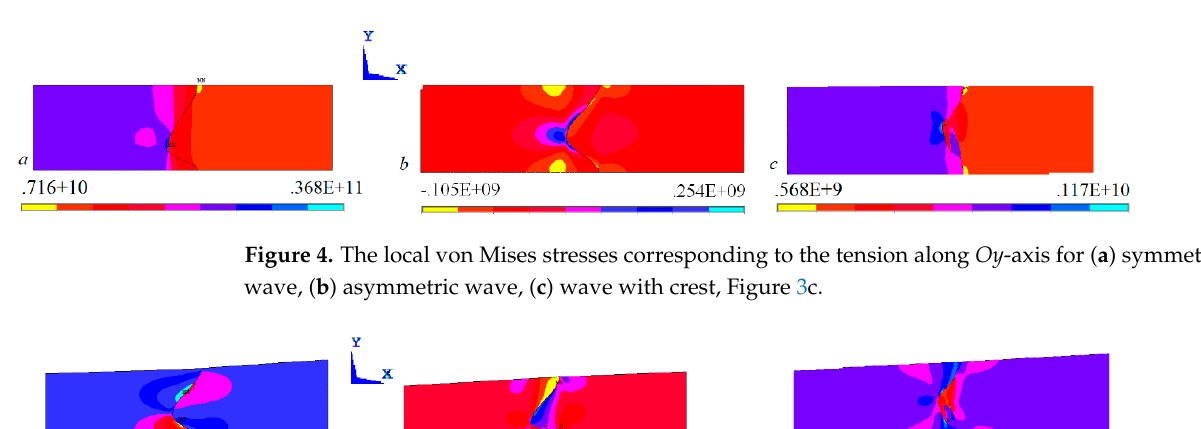
Figure 3. The local von Mises stresses corresponding to the tension along Ox -axis for ( a ) symmetric wave, ( b ) asymmetric wave, ( c ) wave with crest, Figure 3c.